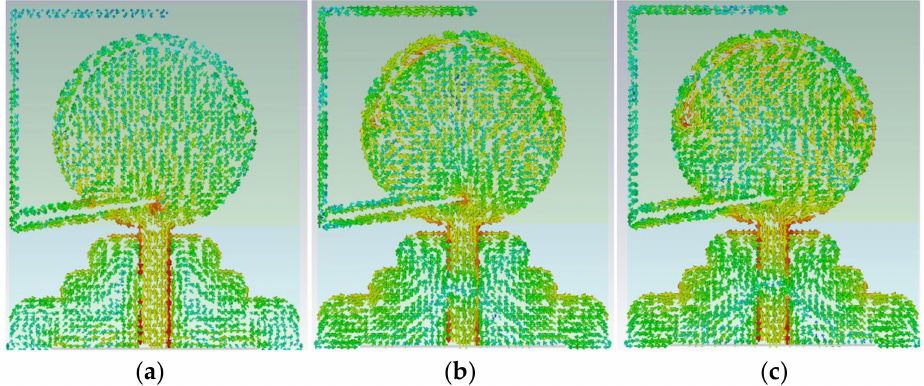
Figure 4. The antenna’s surface current distribution (SCD) result at poles in bandwidth (BW) at ( a ) 2.5 GHz, ( b ) 4.45 GHz, and ( c ) 6.8